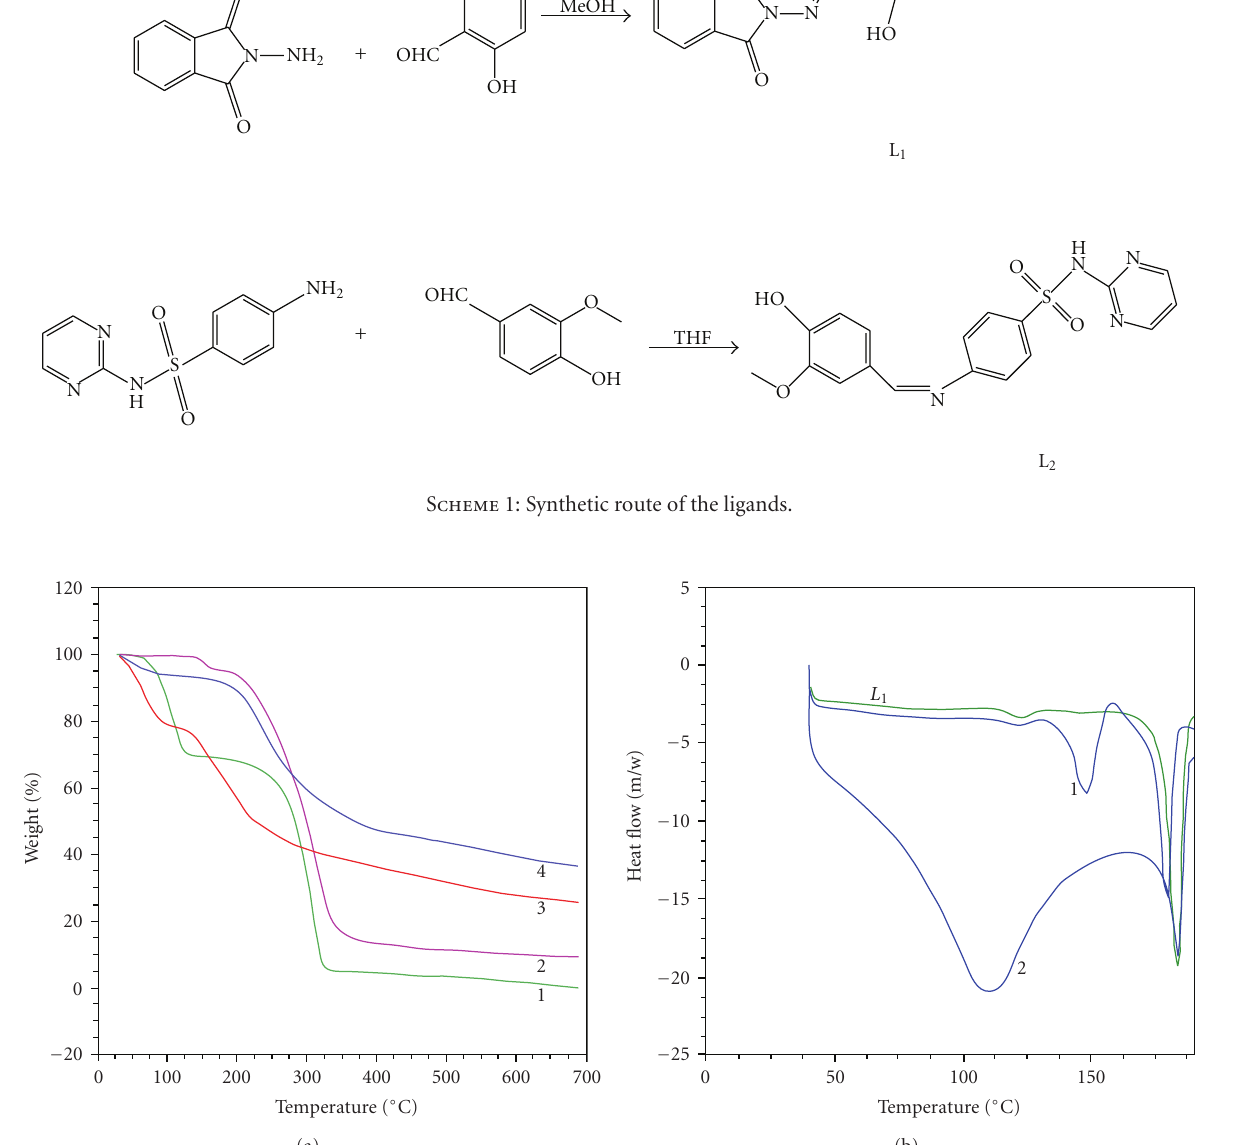
Figure 1: (a) Thermogravimetric (TGA) curve of organotin(IV) complexes ( 1–4 ) and (b) DSC curve of ligand (L 1 ) and complexes ( 1 and 2 ). Table 1: Analytical data and some physical properties of the Schi ff base ligands and their organotin(IV) complexes. Compound Mol.